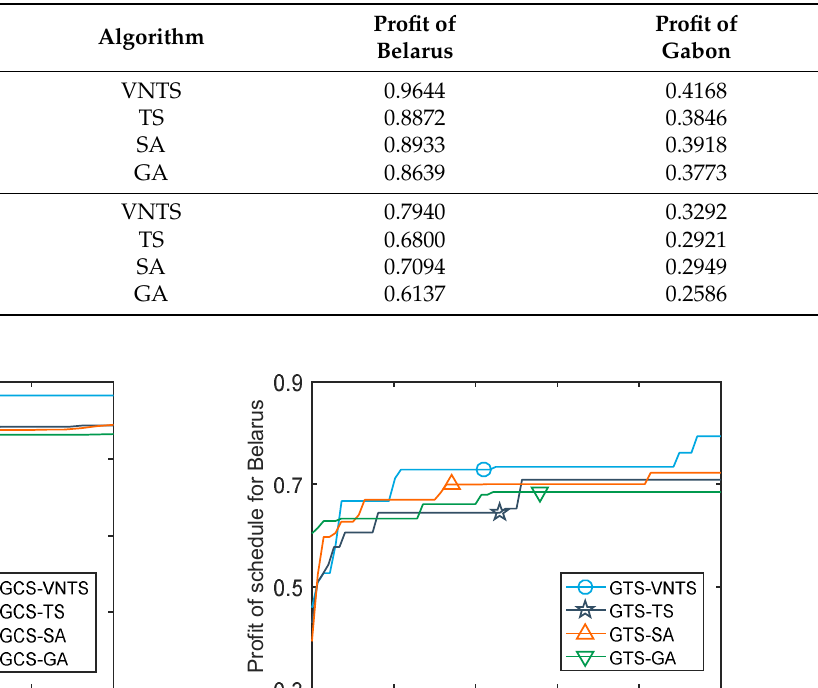
Table 4. Simulation results of four algorithms under GCS and GTS methods.